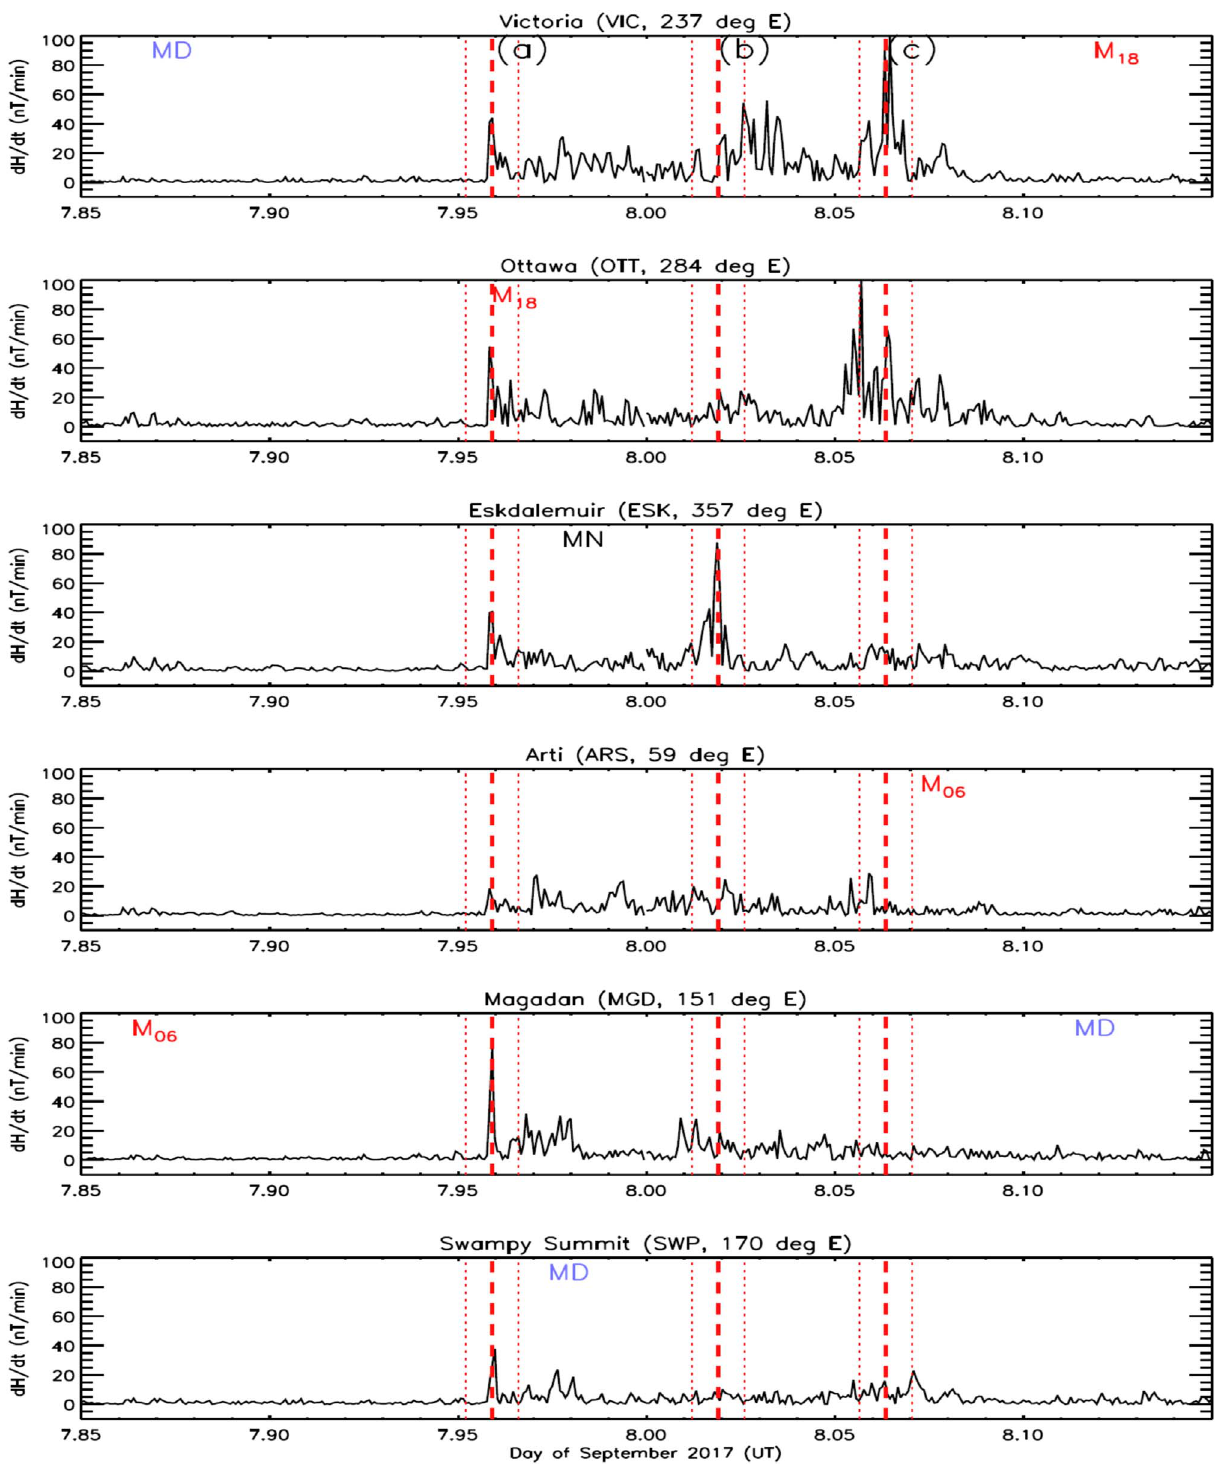
Fig. 3. Rate of change of the H -component of magnetic fi eld at sites close to 53 (cid:1) magnetic latitude, during Interval 1, i.e. spanning 7 – 8 September 2017. Observatory sites used are longitudinally spaced around the globe, starting with Canada at the top and progressing eastwards to New Zealand at the bottom. Times of large d H /d t are indicated by red dashed lines, and identi fi ed by (a) – (c) in the upper most panel. Vertical dotted lines indicate a time window of ±10 min around each event. The times of local magnetic midnight (MN), dawn (M 06 ), dusk (M 18 ), and midday (MD) are shown on the